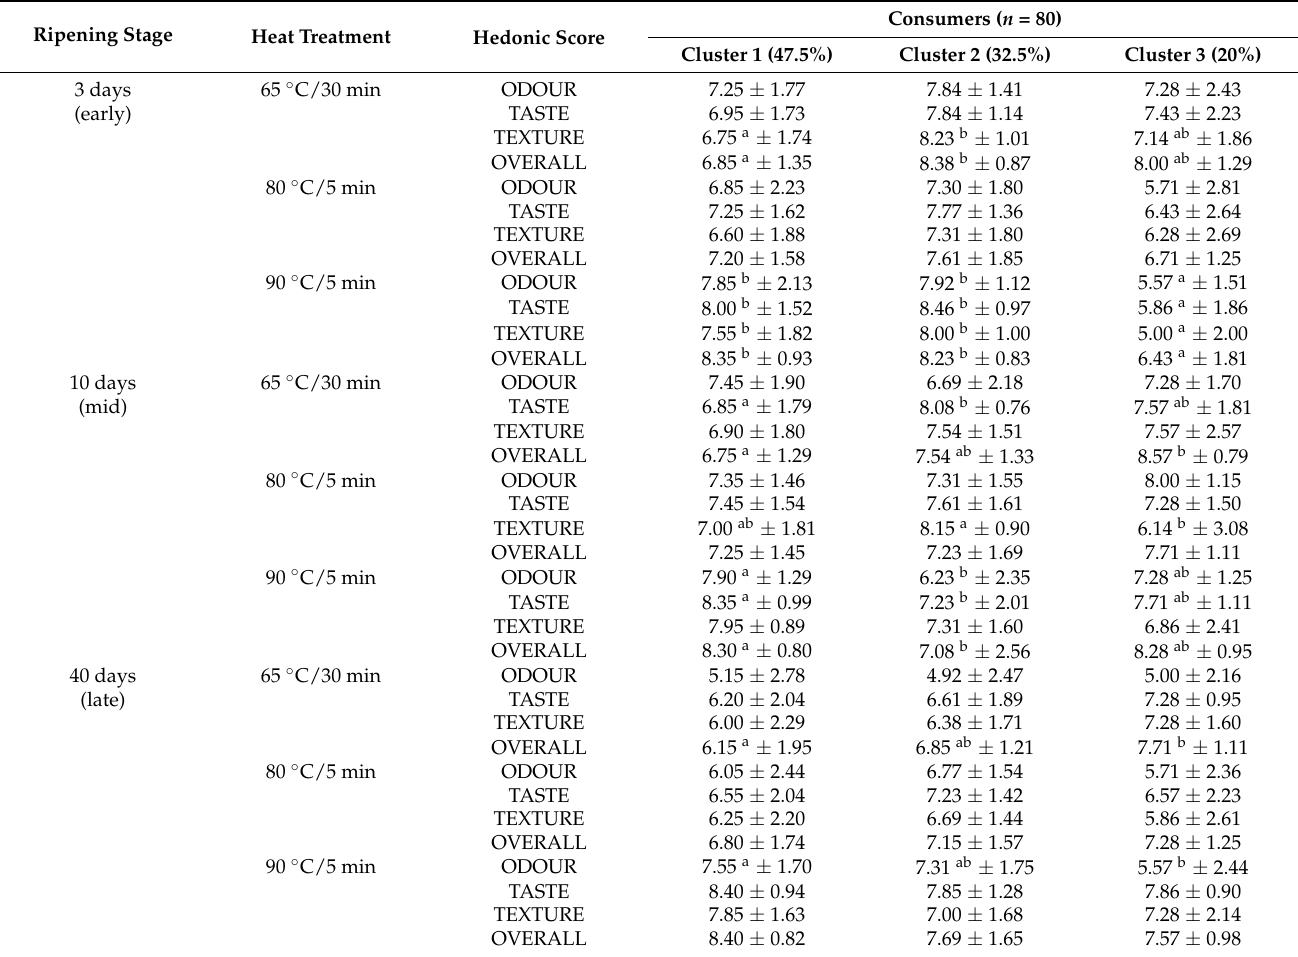
Table 3. Consumer hedonic test scores for goat cheeses produced from milk heated by three different treatments, in the early, mid and late ripening